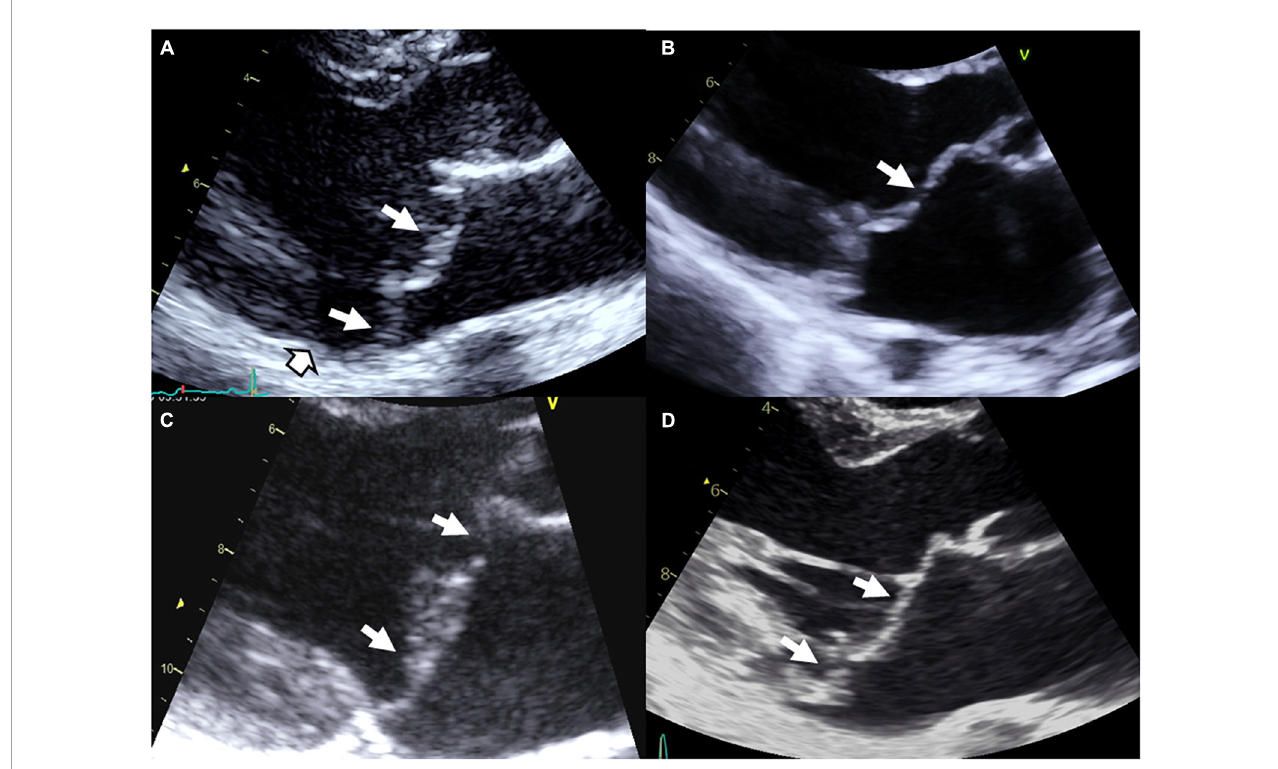
FIGURE1 Syndromic and non-syndromic mitral valve prolapse/dystrophy. (A) Marfan syndrome with bileaflet myxomatous MVP, (B) Williams–Beuren syndrome with a history of operated supra-valvular aortic stenosis, mild billowing/prolapse of the anterior leaflet and restrictive motion of the posterior leaflet with moderate MR, (C) Filamin A MVP/dystrophy, and (D) bileaflet myxomatous MVP diagnosed after a resuscitated sudden death inaugurating the disease. White arrows: Prolapse/billowing, black and white head arrow: Mitral annular disjunction common in arrhythmic